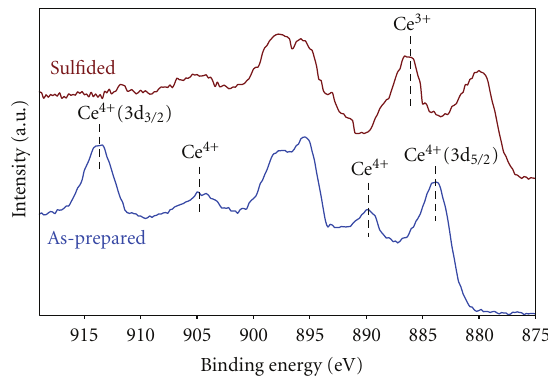
Figure 13: Comparison of the XPS signature of virgin GDC sample with that sulfided at 800 ◦ C for 16h in a gas stream containing 300ppm H 2